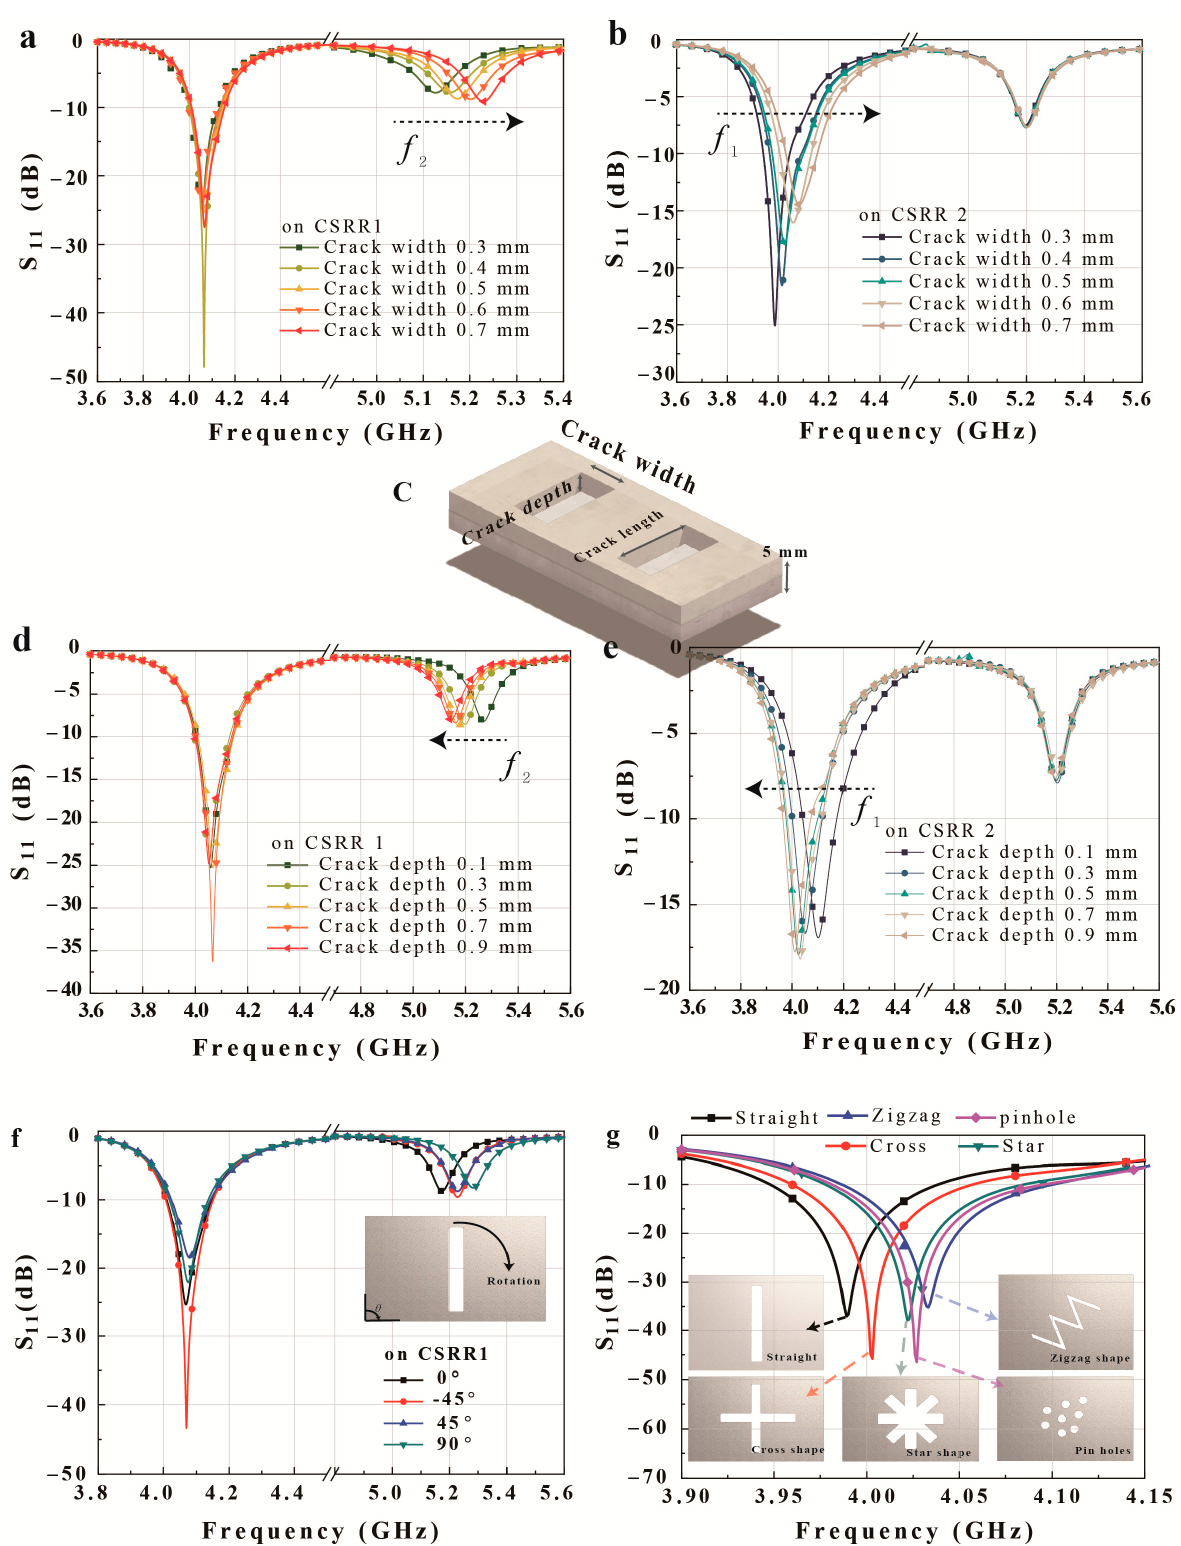
Figure 4. Simulated S11 results for the proposed dual-crack sensor for different crack widths above ( a ) CSRR1 and ( b ) CSRR2. ( c ) Fundamental metal sheet structure with two cracks with a width, depth, and length of 0.5 × 0.9 × 6.1 mm. S11 results for different crack depths above ( d ) CSRR1 and ( e ) CSRR2. ( f ) S11 results for the rotation of a straight crack above CSRR1. ( g ) S11 results for five crack shapes above CSRR2.